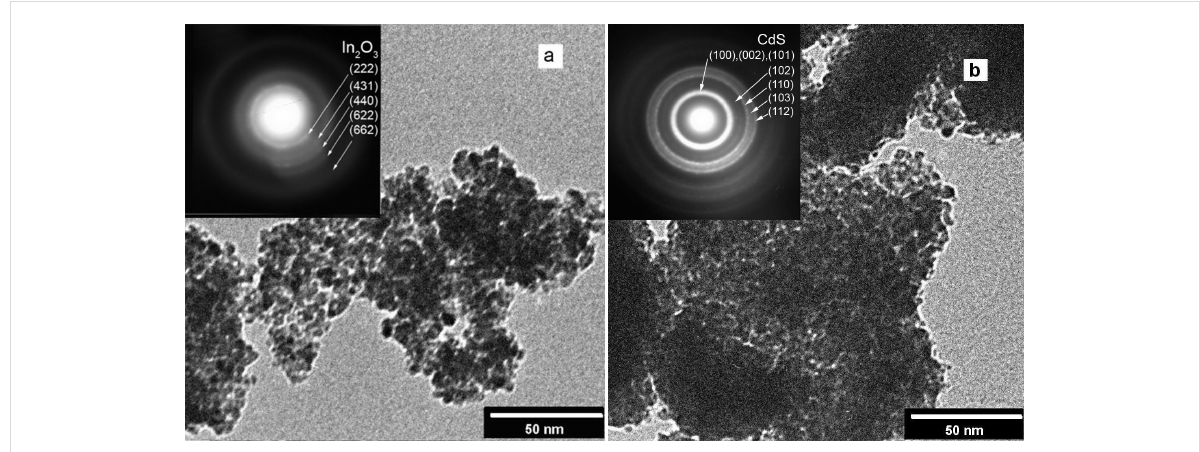
Figure 1: TEM images and electron diffraction patterns (insets) for In 2 O 3 (400) (a) and In 2 O 3 (400) after 30 SILAR CdS deposition cycles (b).